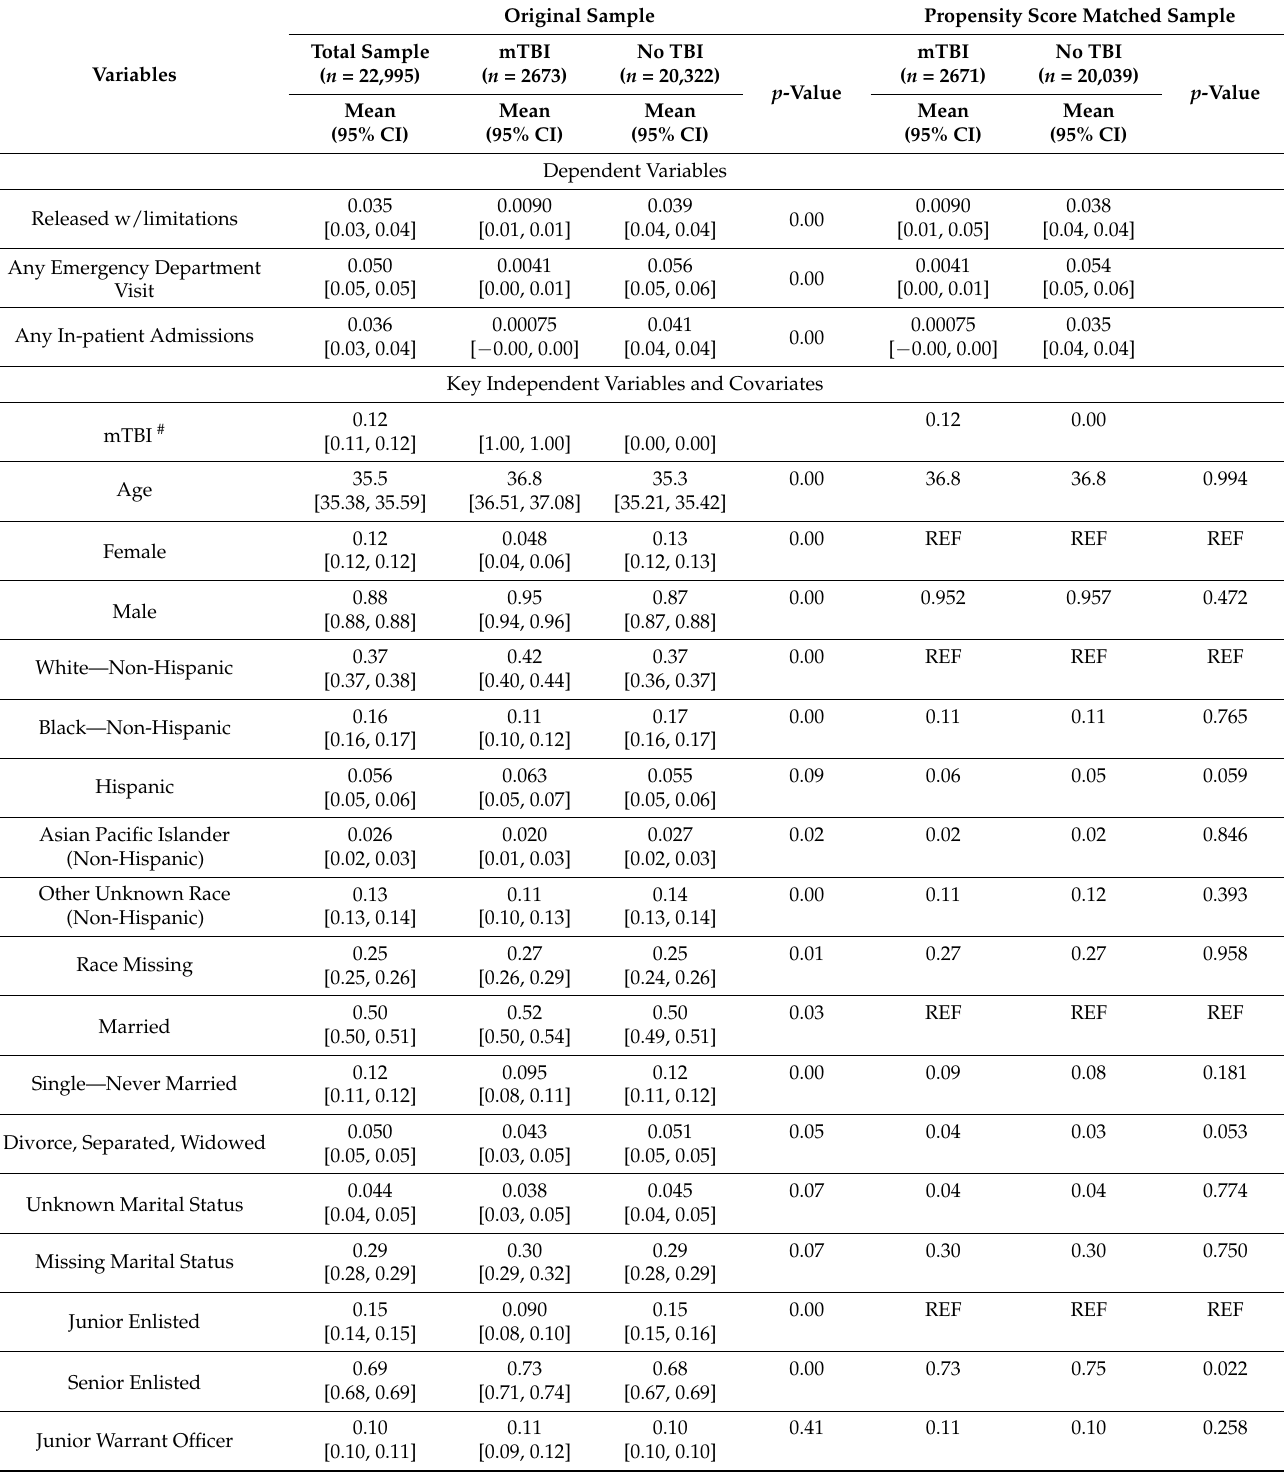
Table 1. Summary statistics of dependent and socio-demographic variables, Military Health System data repository,